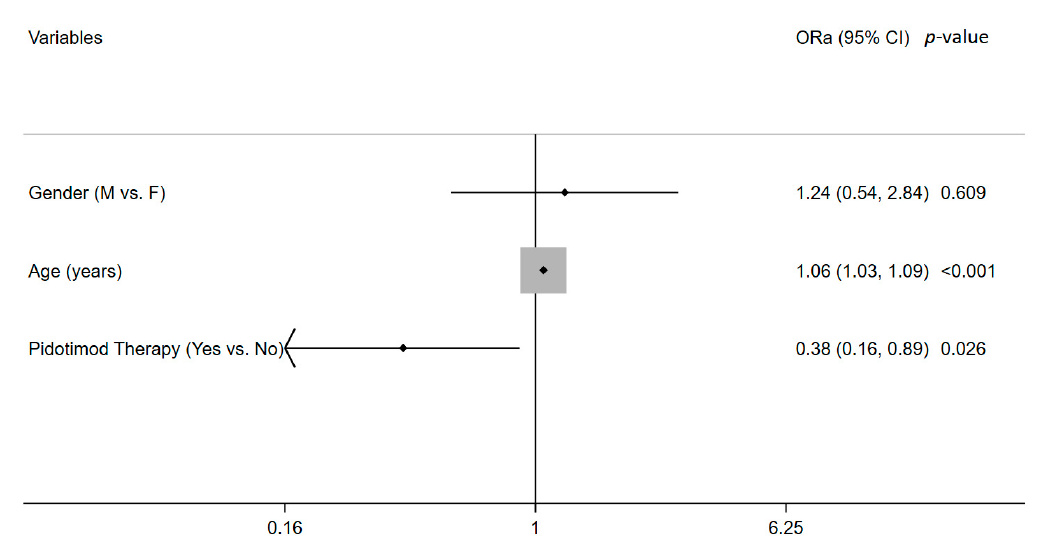
Figure 2. Logistic regression for ER access/hospitalization; Ora = adjusted odds ratio; 95% CI = 95% interval confidence.